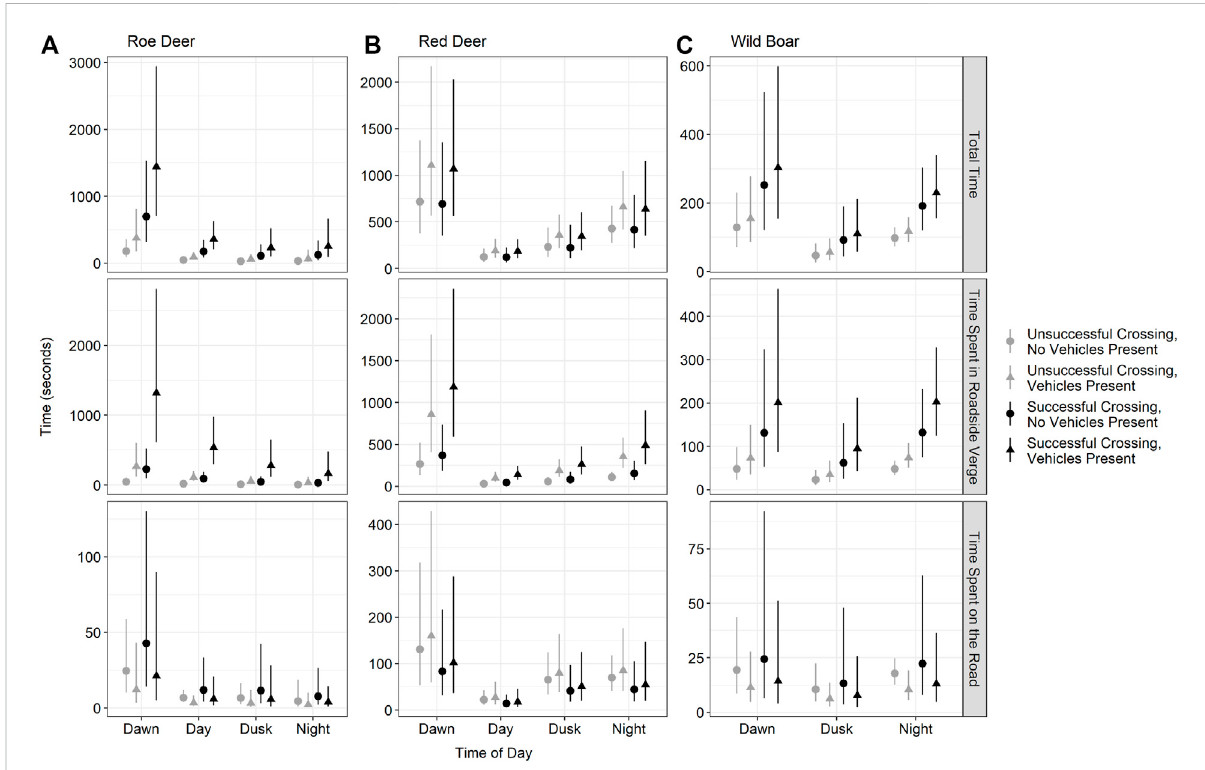
FIGURE 3 Predicted amount of time, in seconds, roe deer [left- (A) ], red deer [middle- (B) ] and wild boar [right- (C) ] spent in the at-grade fauna passage overall (total time, top), in the roadside verge (middle) and on the road (bottom). Grey points show events with unsuccessful crossings, while black points show events with successful crossing. Circles indicate events while no vehicles are present, and triangles are events where vehicles are present. Error bars are 95% con fi dence intervals. Note: the y -axes differ to facilitate